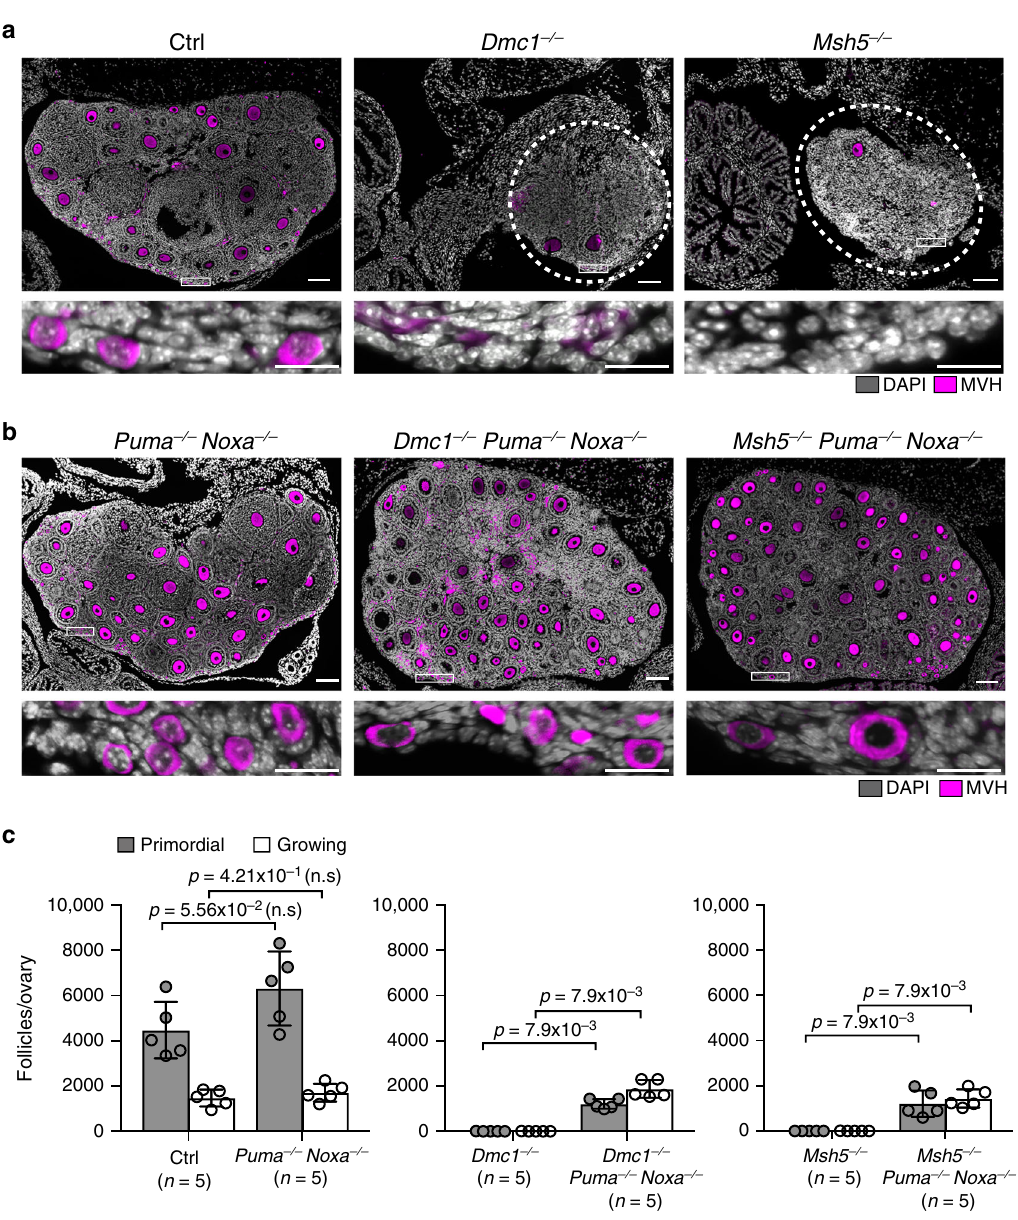
Fig. 1 Puma and Noxa deletion rescues oocyte loss in Dmc1 and Msh5 nulls. a , b P21 ovary sections immunostained for oocyte marker MVH (magenta). Control (Ctrl) is Dmc1 + / − Puma + / − Noxa + / − . White rectangles in upper panels show cortex, which is magni fi ed in lower panels. Dotted circles outline degenerated ovaries ( n = 5 females, N = 3 experimental repetitions). Scale bar in upper panels 100 μ m, scale bars in micrographs 25 μ m. c Primordial and total follicle quantitation at P21. Data are represented as mean ± standard deviation. Error bars indicate 95% con fi dence intervals. Two-sided Mann – Whitney test was used to calculate p